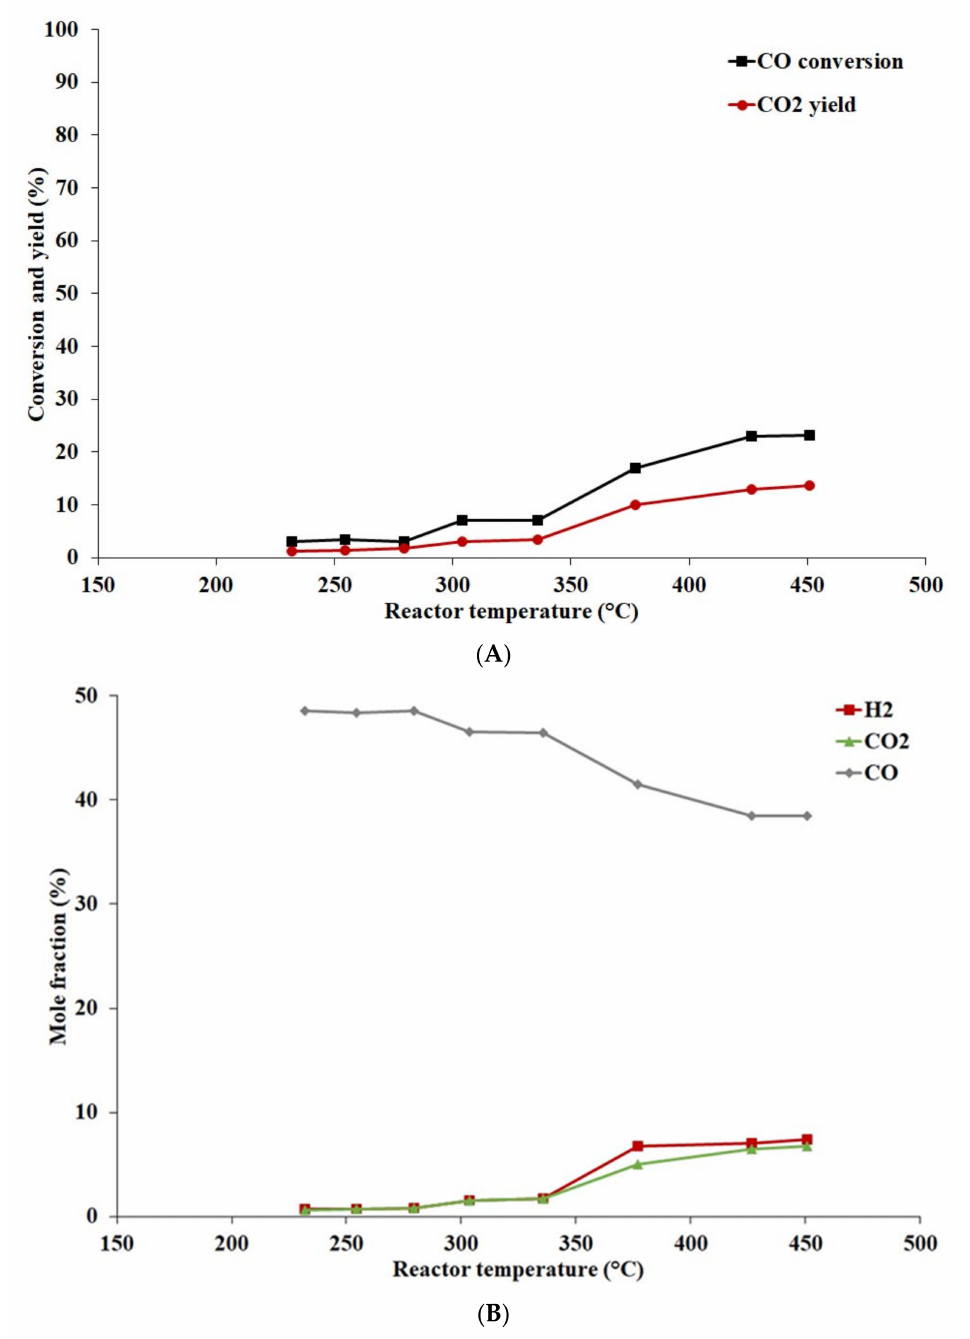
Figure 21. Catalytic tests with feed gas mixture 1 (50 mole% CO, 50 mole% N 2 ) at pressure 0.5 MPa over sulphided Co-based (9.6 wt%) catalyst. ( A )—CO conversion and CO 2 yield; ( B )—composition of the gas